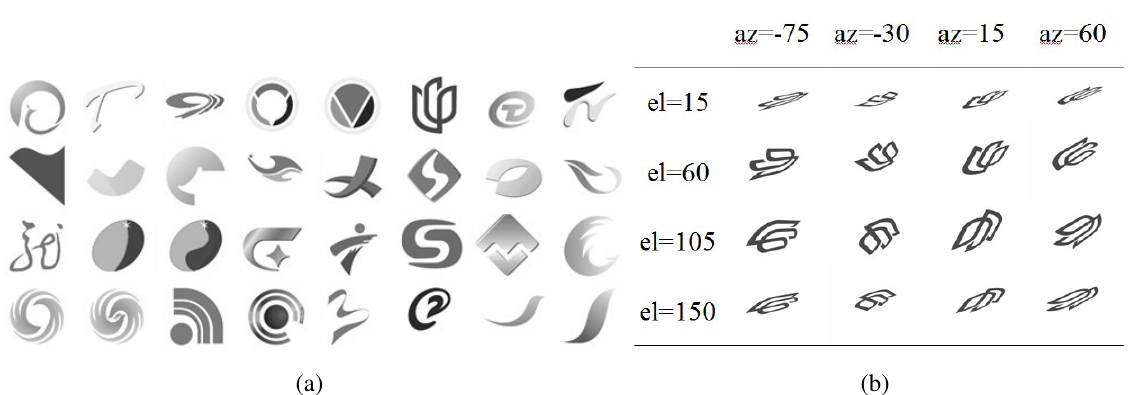
Figure 6. Experimental set: ( a ) 32 logos of television networks; and ( b ) an example subject to perspective transformations with the perspective factors ( α, β ) = (0 . 5 , 0) and various ( az , el ) (azimuth (az) and elevation (el))